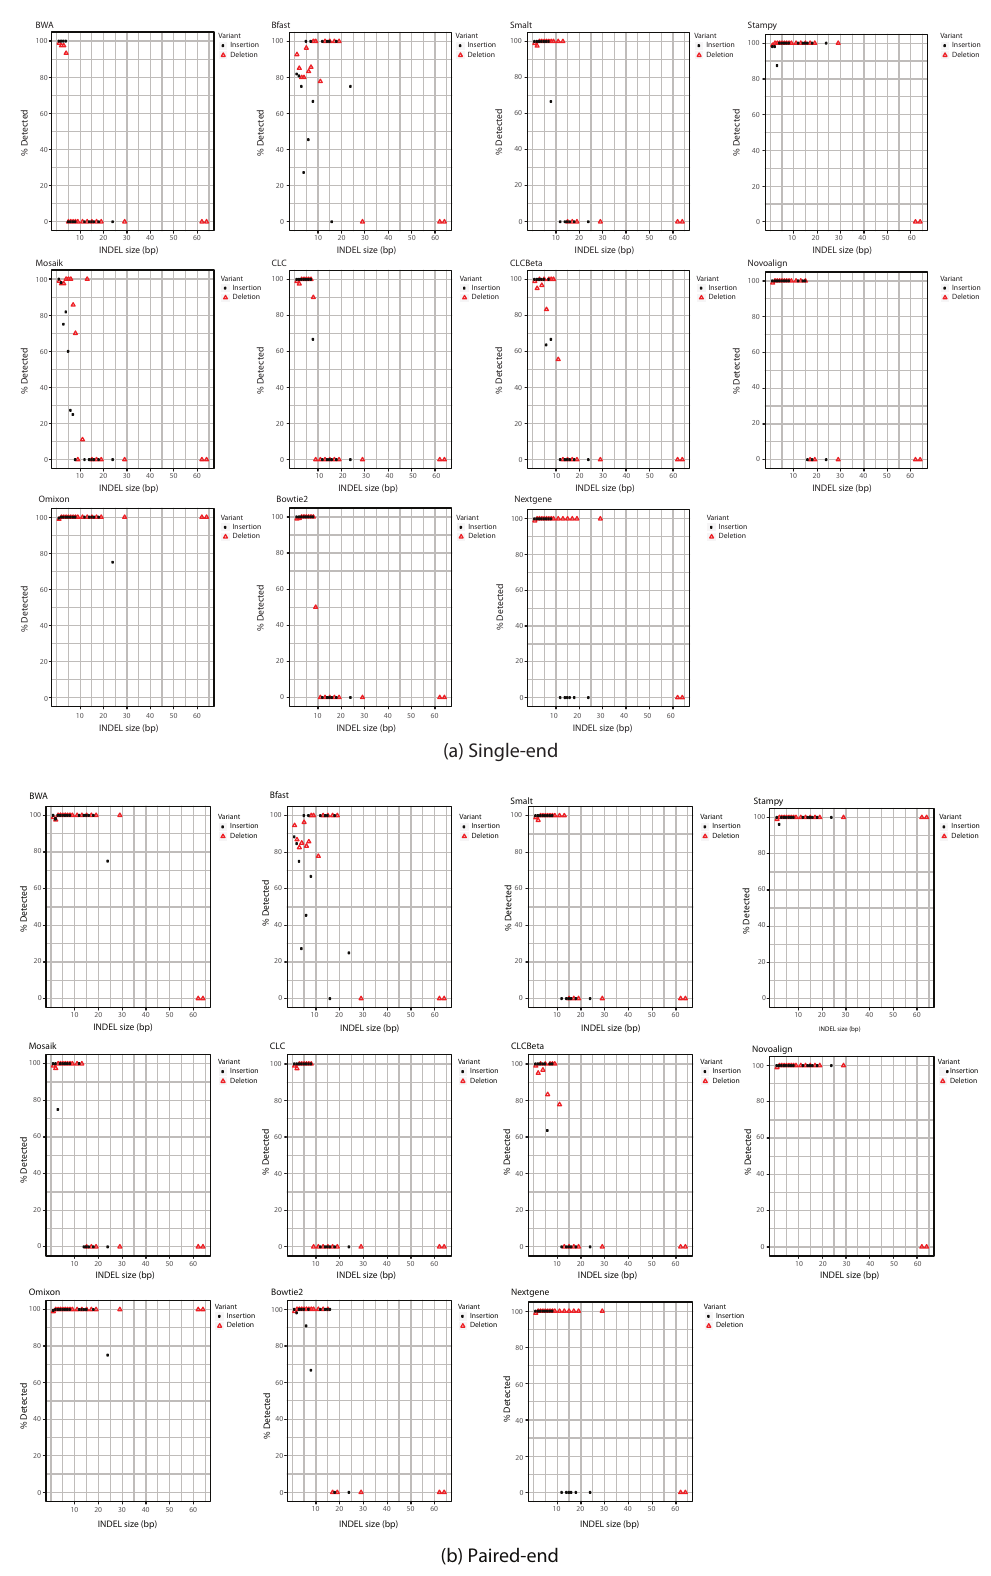
Figure 3. Effects of INDEL size on success of detection for all aligners in single-end (top panel) and paired-end (bottom panel) mode across 67 groups of simulated Illumina reads, each containing 13 INDELs of varying